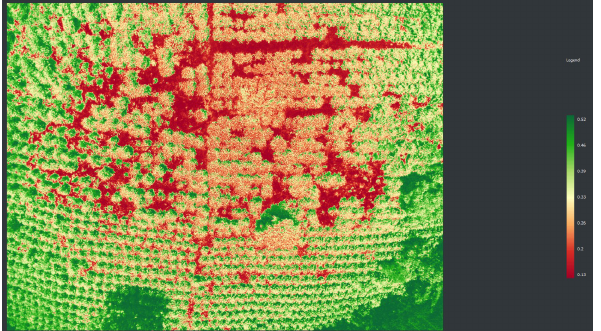
Figure 6. Sunny NDVI image map.